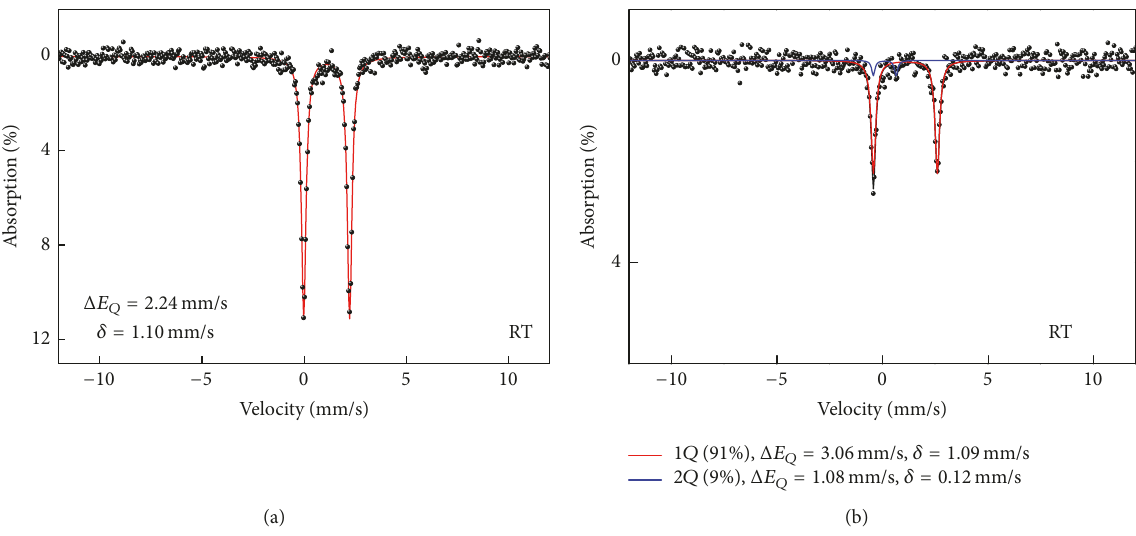
Figure 2: The room temperature M¨ossbauer spectra of (a) ferrous fumarate and (b) ferrous